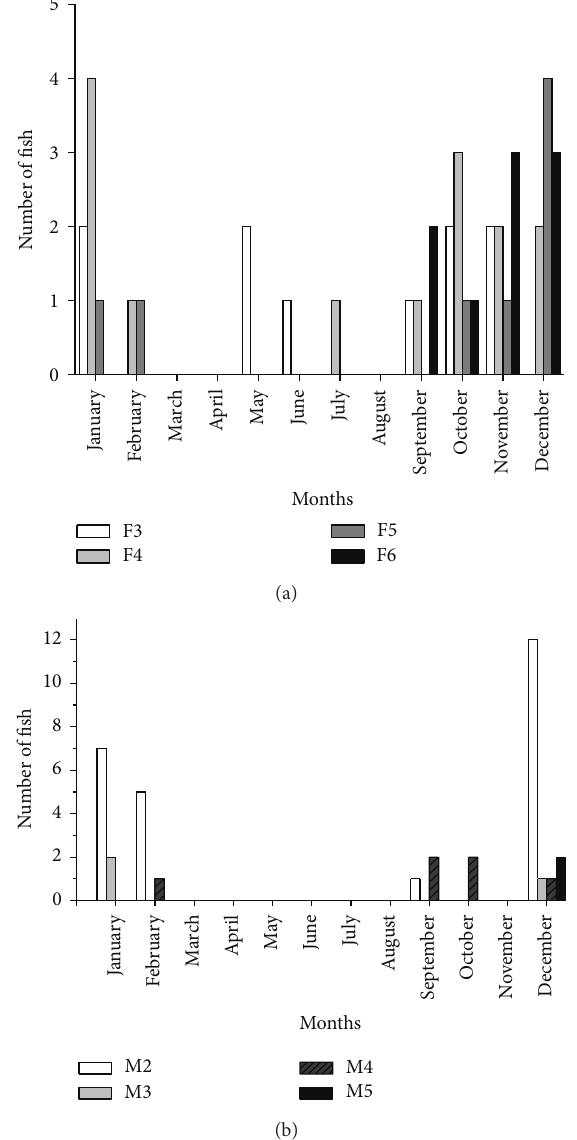
Figure 9: Monthly distributions of (a) female and (b) male Epi- nephelus malabaricus according to maturity